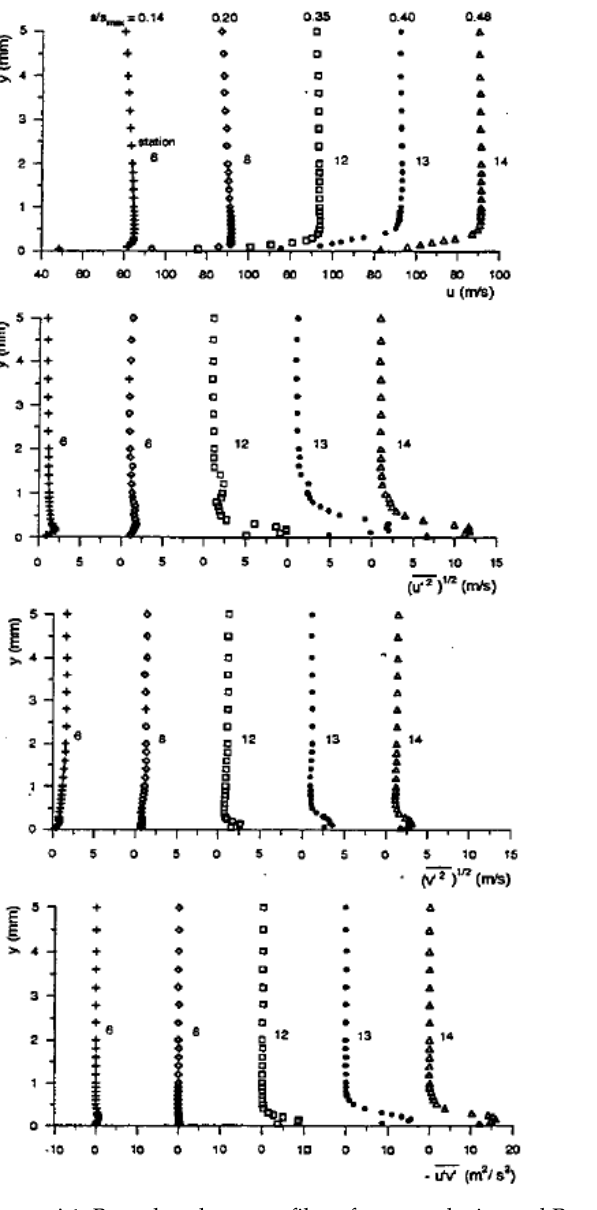
Figure A1. Boundary layer profiles of mean velocity and Reynolds stress components; ( left ): forward blade suction side; ( right ): rear blade suction